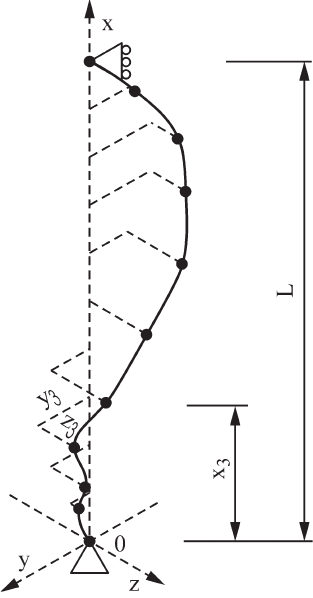
Fig. 5. Example of spatial depiction of the